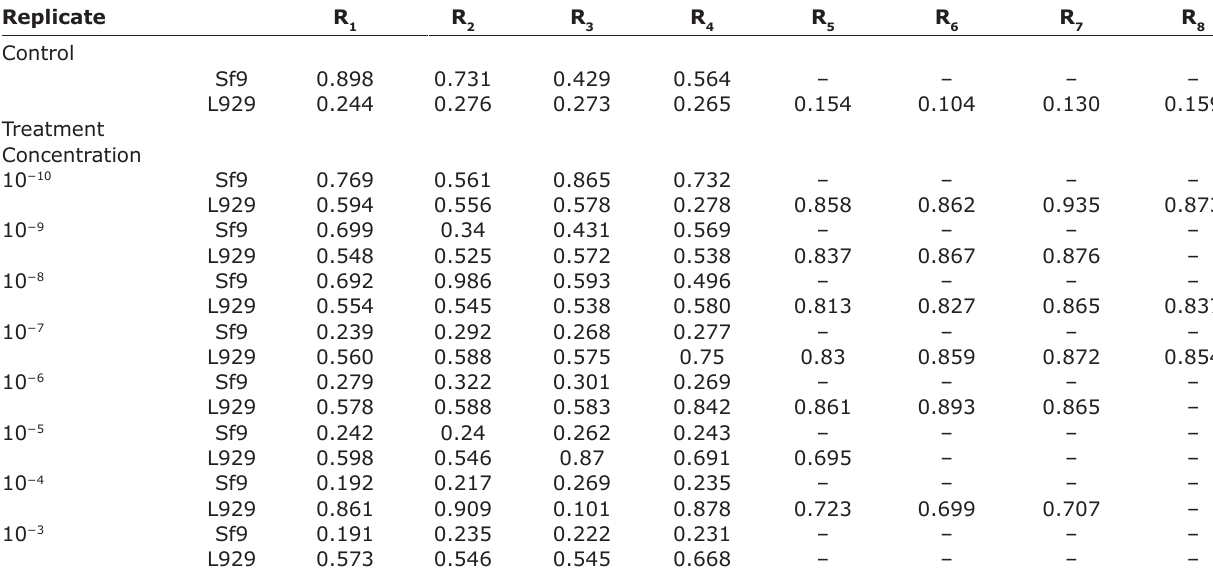
Table-1: Cytotoxicity of Nepeta crispa essential oil (ng/μL) against invertebrate (Sf9) and vertebrate (L929) cell lines. Replicate Control